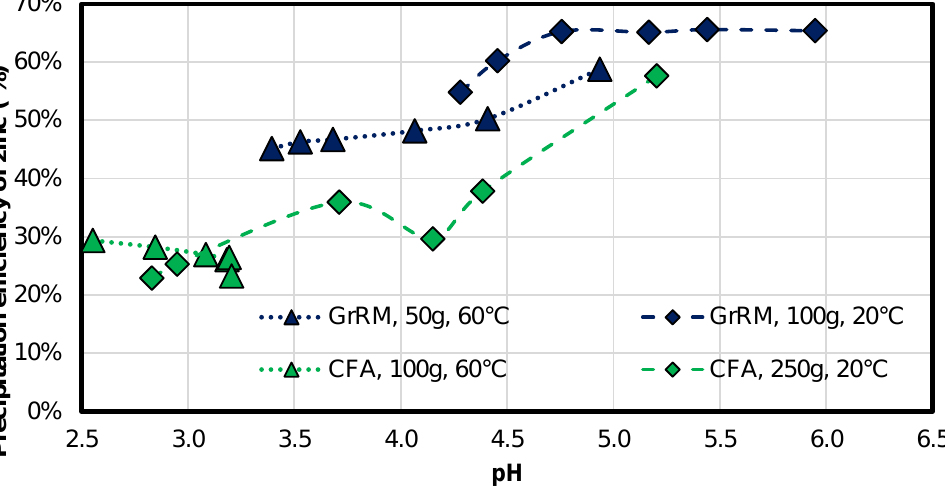
Figure 10. Participation efficiency of zinc.